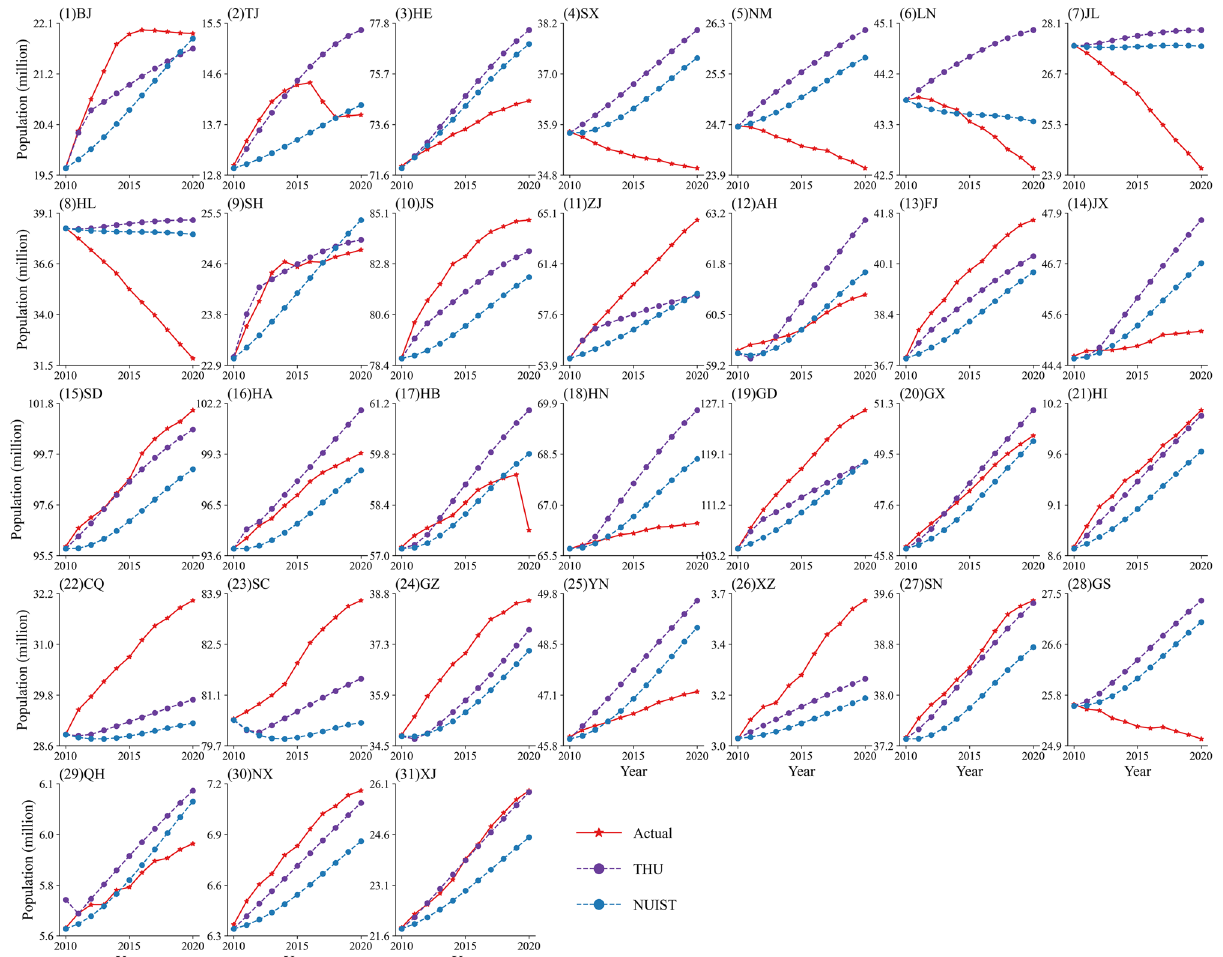
Figure 3. Comparison between actual and projection population at the province scale. The subfigures from (1) to (31) represent different provinces. The vertical axis is the population number (unit: million), and the horizontal axis represents the validation years from 2010 to 2020. The red star indicates the actual provincial population, the blue circle represents the NUIST, and the purple circle denotes the and the middle region has the lowest values. As a result, both THU and NUIST have large errors in northeast China and Xizang province.